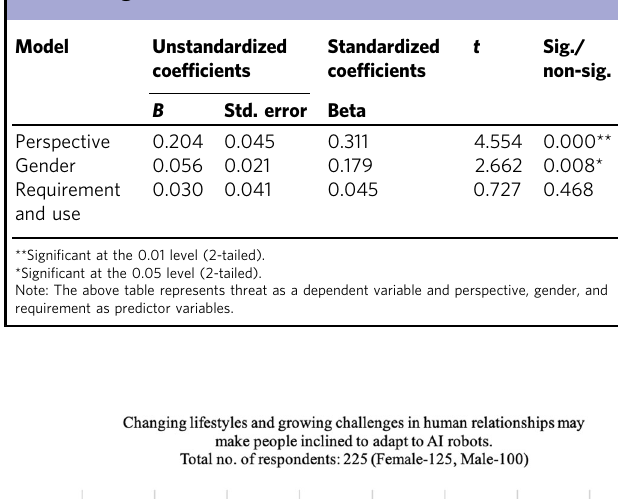
Table 1 Correlation table.